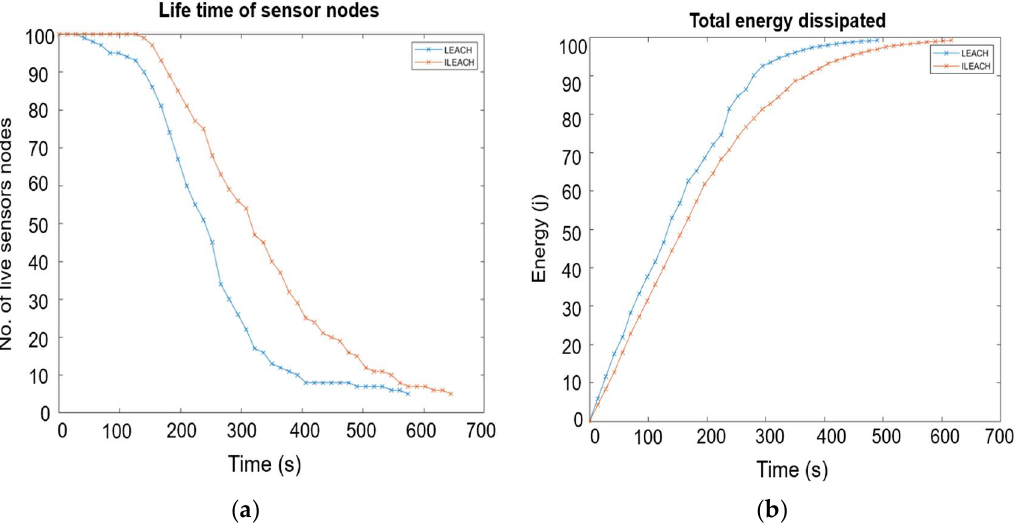
Figure 8. Comparisons of lifetime and average energy consumption of sensor nodes between standard LEACH and improved LEACH protocol in ( a , b ), respectively.